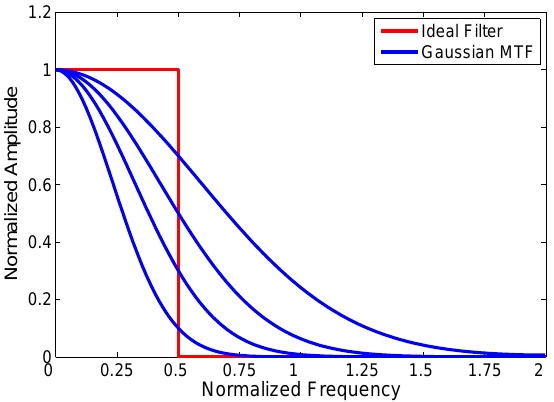
Figure 1. Frequency responses of some Gaussian-like MTFs versus the ideal